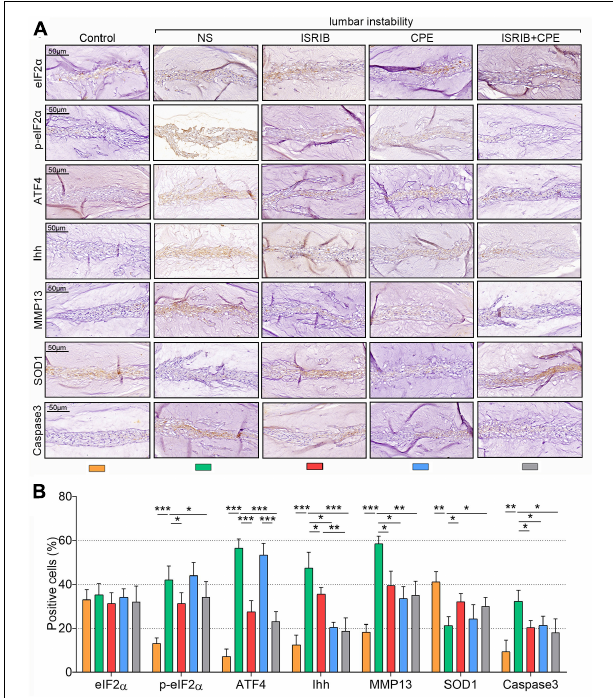
FIGURE 7 | ISRIB and CPE treatment exerted anti-hypertrophy and anti-apoptosis effects of NP cells in vivo . The mice were treated with the procedure described above. (A) Representative micrographs of slices stained with eIF2 α , p-eIF2 α , ATF4, Ihh, MMP13, SOD1, and Caspase3. (B) Quantitation of percentage of total positive cells (%) (scale bar = 50 µ m). Data are presented as means ± SD ( n = 6). * p < 0.05; ** p < 0.01; *** p < 0.001; the orange column indicates control mice without lumbar surgery to induce instability, the green column indicates mice injected with NS after lumbar surgery, the red column indicates mice injected with ISRIB after lumbar surgery, the blue column indicates mice injected with CPE after lumbar surgery, and the gray column indicates mice injected with ISRIB and CPE after lumbar surgery. CPE, cyclopamine; NP, nucleus pulposus; eIF2 α , eukaryotic initiation factor-2 α ; p-eIF2 α , phosphorylated eukaryotic initiation factor-2 α ; ATF4, activating transcription factor 4; Ihh, Indian hedgehog; MMP13,